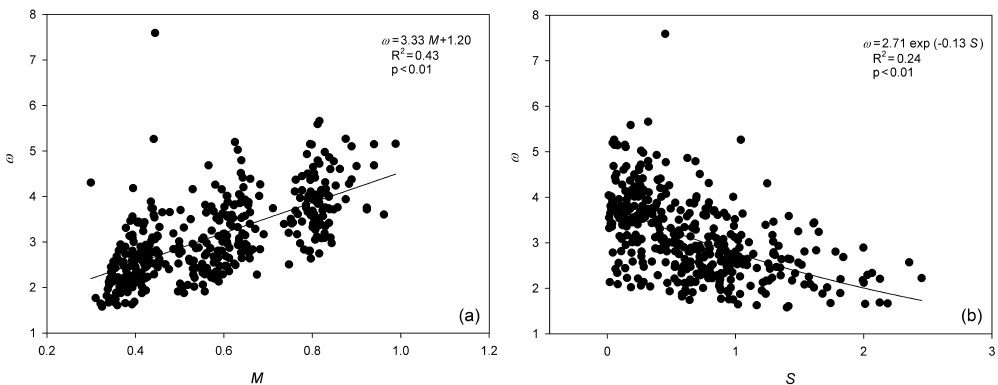
Figure 3. Relationship between the (a) annual ω and vegetation coverage ( M ) and (b) ω and climate seasonality index ( S ) based on the combined dataset from 13